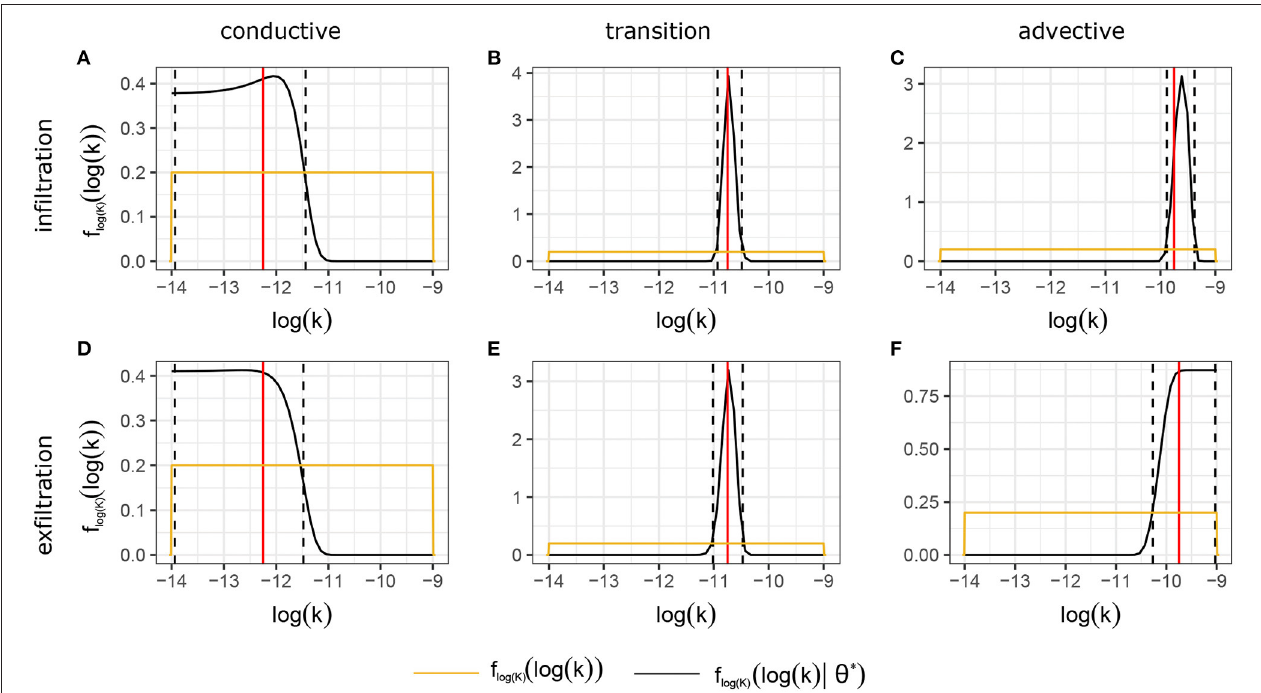
FIGURE 4 | Prior (in yellow) and posterior (in black) distributions for log-transformed permeability. Panels a-f refer to the hydrological and thermal regimes as defined in Table 4 . The vertical red bars are values of underlying parameters used to generate synthetic measurements θ ∗ . The dashed black lines represent the bounds of the 95% credible intervals. For all regimes, the underlying value for the intrinsic permeability is located within the credible interval, which confirms that the algorithm correctly infers the interval where intrinsic permeability is located based on the observed temperature time series. Posterior distributions are always narrower than priors, showing that temperature time series are always helpful for characterizing intrinsic permeability values. The posterior distributions are narrower for transition and advection cases, for conductive cases intrinsic permeability values are characterized to be lower than the upper bound ∼ 10 − 12 m 2 , i.e., a hydraulic conductivity value of ∼ 10 − 5 m · s − 1